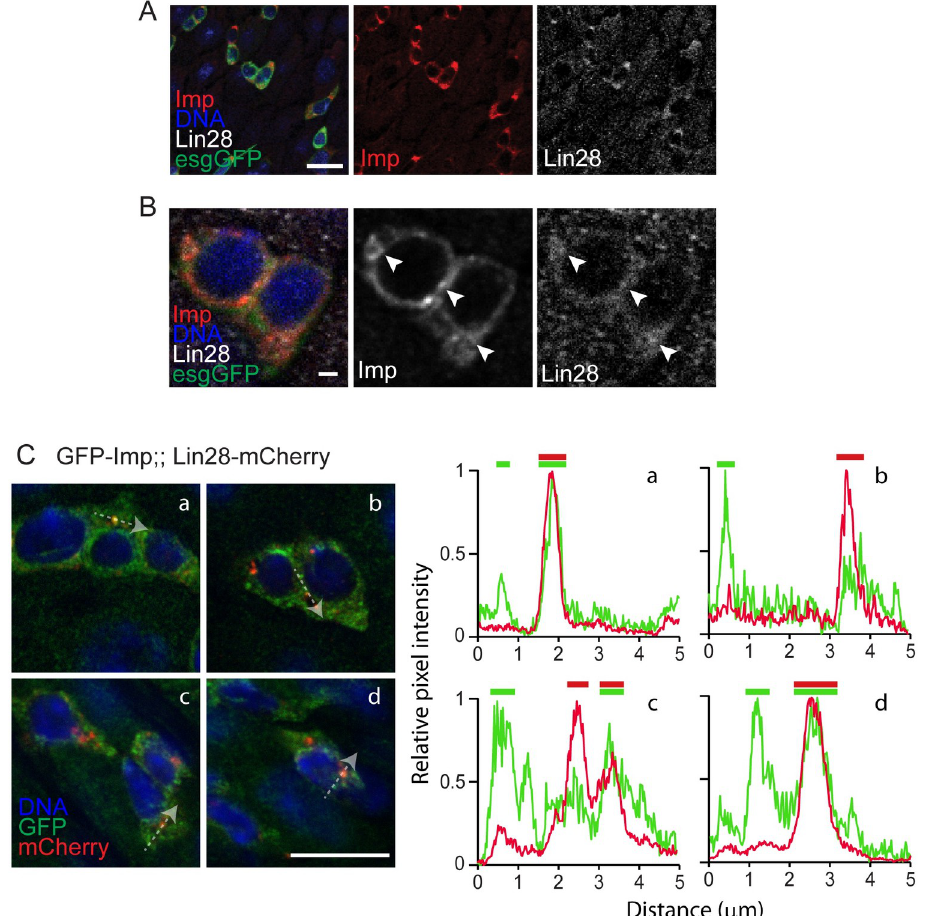
Fig 6. Imp and Lin28 partially co-localize in vivo . (A) Representative confocal image showing the co-localization of Imp and Lin28 endogenous proteins detected using specific antibodies in wildtype gut. In these 7-day old esgGFP ts > GFP kept at 29˚C for 5 days, GFP expression marks esg-positive ISCs and EBs. DNA is stained with Hoechst. Imp and Lin28 proteins are expressed in similar patterns in these cells. Scale bar: 10 μ m. (B) High magnification images of the same conditions as in (A) show both Imp and Lin28 proteins form detectable and partially overlapping foci in the cytoplasm of esg-positive cells. Scale bar: 1 μ m. (C) Confocal images of the intestine of GFP-Imp and Lin28-mCherry trans-heterozygotes stained with anti-GFP and anti-mCherry antibodies. Both proteins form partially overlapping cytoplasmic foci. Four groups of esg-positive cells are shown as examples. For each, the relative fluorescence intensity profiles in both GFP and mCherry channels are reported along a 5 μ m traced line (highlighted by the dashed line arrows). This quantification illustrates the partial correlation between the signals.